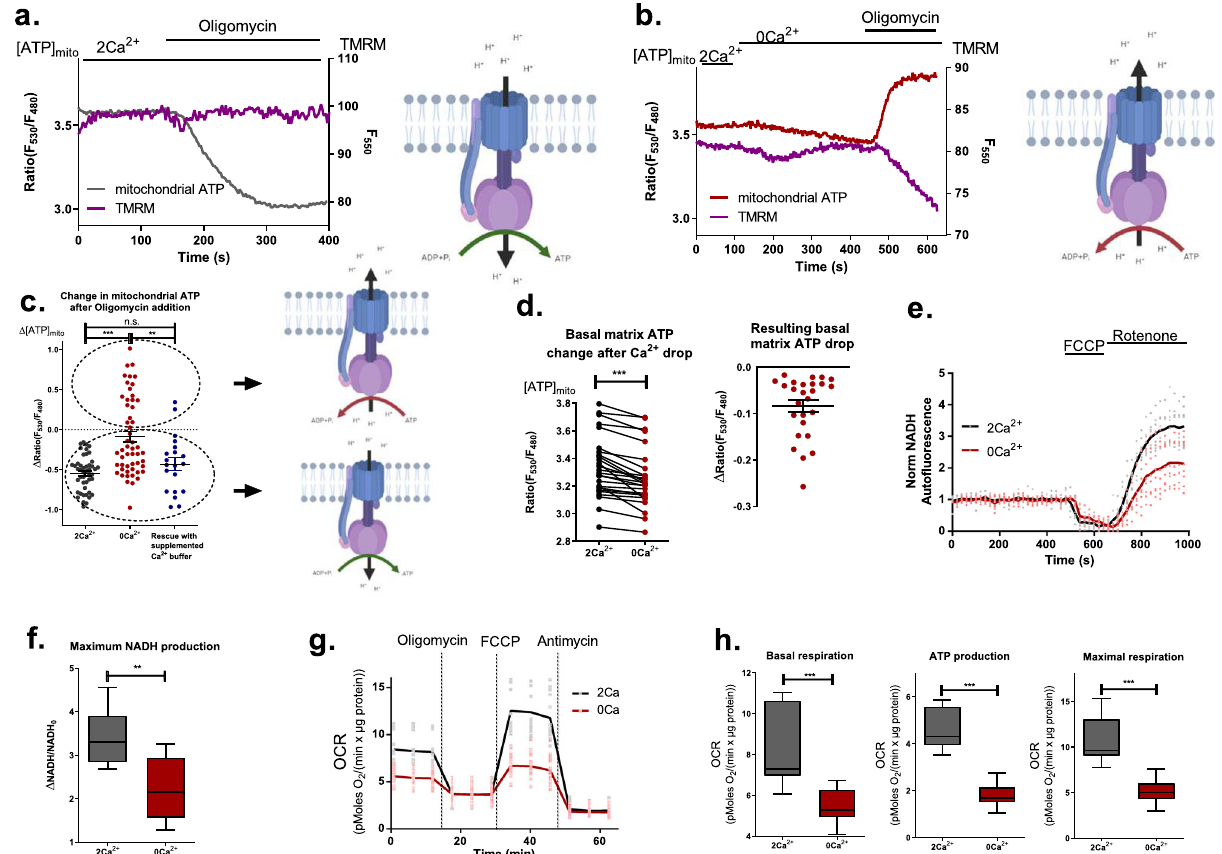
Fig. 2 Perturbance of basal Ca 2 + homeostasis alters mitochondrial bioenergetics. a Representative control traces of simultaneous measurements of [ATP] mito and Ψ mito using mtAT1.03 and TMRM, respectively. On the right, a graphical illustration of the ATP synthase mode is depicted (Created with BioRender.com.). b Representative traces of [ATP] mito and Ψ mito in 0 extracellular Ca 2 + . Graphical representation of the ATP synthase mode is depicted on the right (Created with BioRender.com.). c Statistical analysis of the change in [ATP] mito after 2 µ M oligomycin with graphical illustration of ATP synthase modes on the right (Created with BioRender.com.) (One-way ANOVA with Tukey ’ s multiple comparison test, n = 46 for 2 Ca 2 + , n = 53 for 0 Ca 2 + , n = 20 for the rescue experiment; *** p < 0.001, ** p < 0.01). d Statistical analysis of the change in [ATP] mito after 5 min in 0 Ca 2 + buffer (on the left) (paired t -test, n = 26; *** p < 0.0001). e Average traces (solid lines) and single data points of mitochondrial NADH auto fl uorescence measurements. f